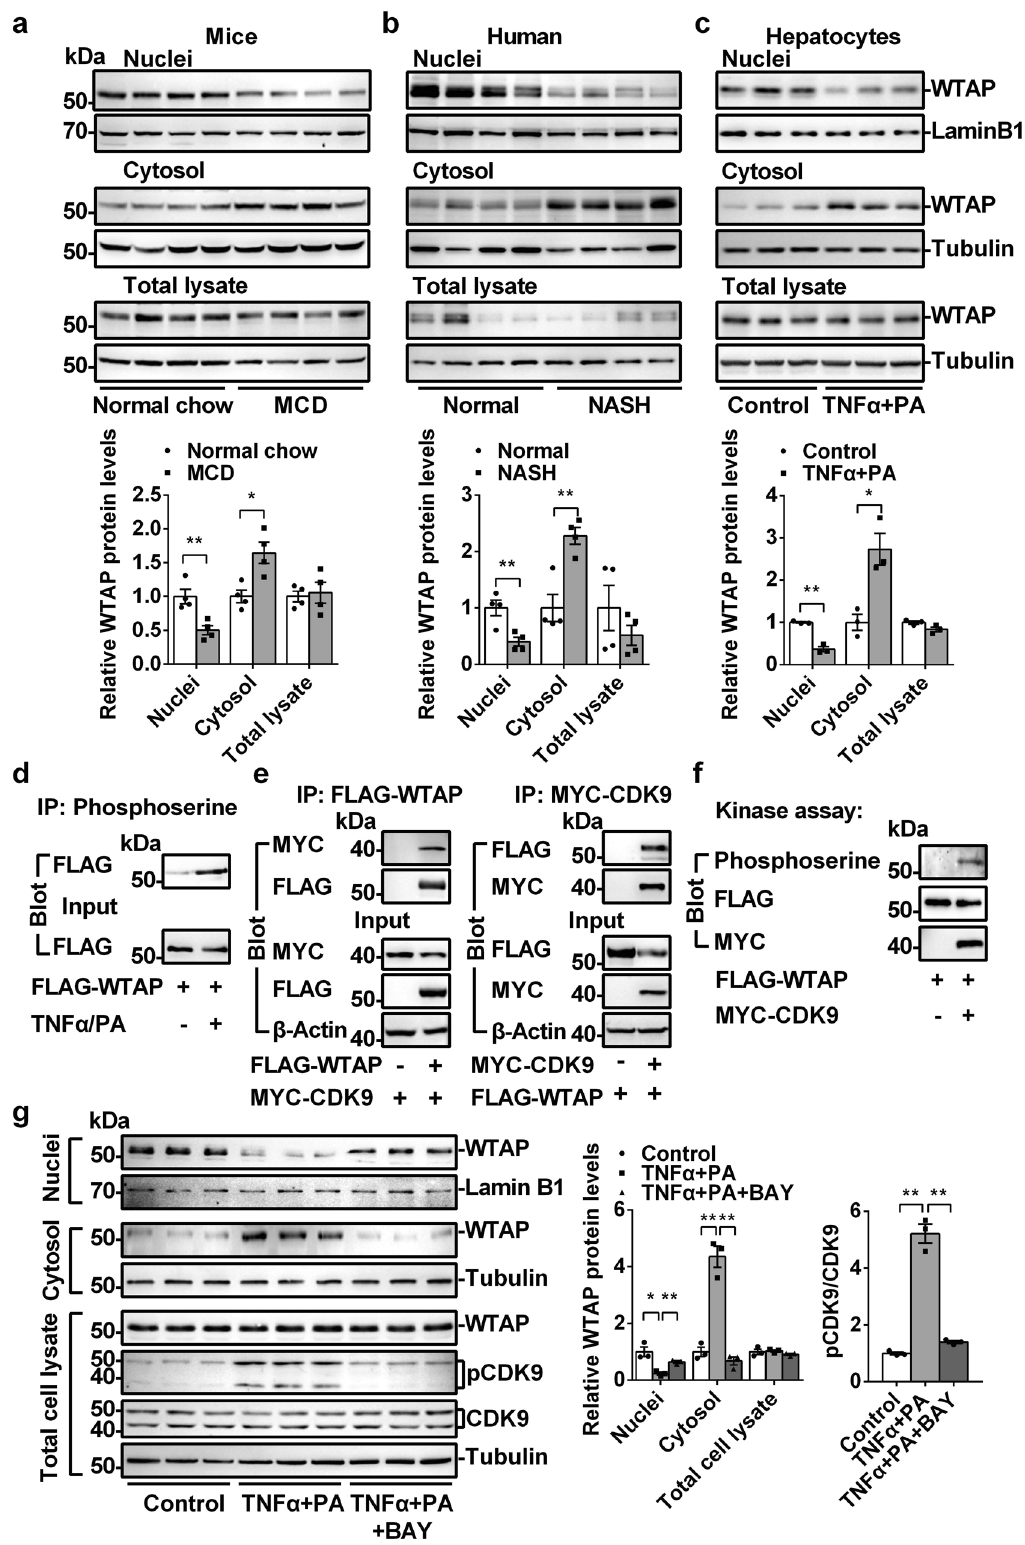
Free Fatty acid uptake assays Wtap fl ox/ fl ox and Wtap -HKO mice were fasted overnight and then injec- ted intraperitoneally with 20 μ M BODIPY FL C 16 for 20min. Small pieces of liver samples were homogenized in a regular RIPA